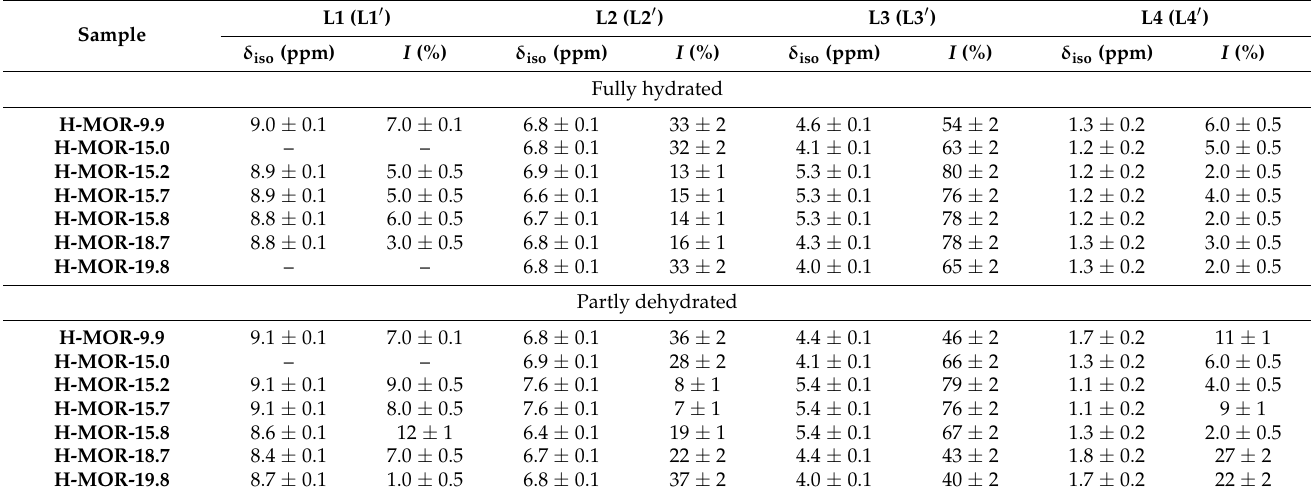
The signal near 1 ppm (L4 and L4 (cid:48) ) is normally attributed to silanol protons